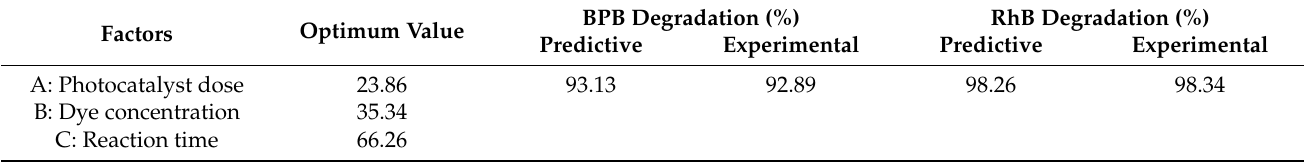
Table 6. Optimum values of the process parameters for constraint conditions and their experimental values.